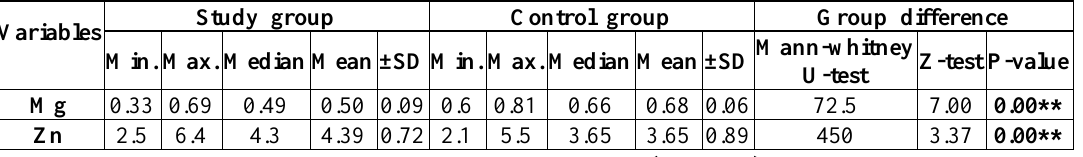
Table 3: Salivary constituents among study and control groups Variables